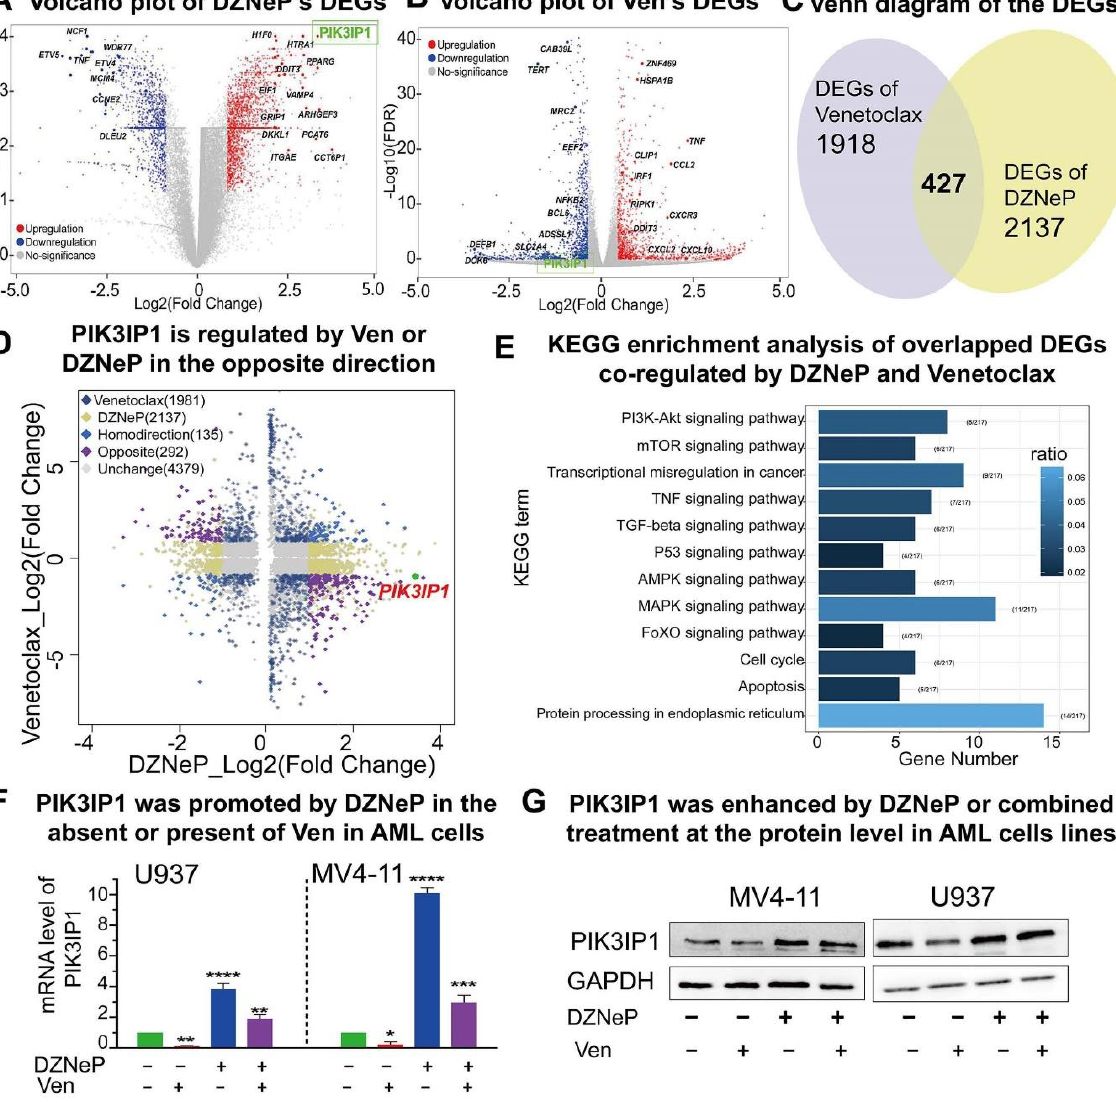
Figure 3. PIK3IP1 plays an important role in the synergistic anti-AML activity upon the combination therapy. ( A , B ) RNA-seq identified different expression genes (DEGs) of DZNeP or Ven treatment compared to the vehicle control in U937 cells. RNA-seq was performed with total RNA isolated from U937 cells treated with 2 μM of DZNeP, 7.5 μM of Ven, or vehicle for 48 h. ( C , D ) RNA-seq analysis identified 427 overlapped DEGs; 135 genes are regulated in the same direction, and 292 genes are regulated in the opposite, among which PIK3IP1 was induced by DNZeP while inhibited by Ven. ( E ) KEGG enrichment analysis of the overlapped DEGs identified the involved pathways co-regulated by DZNeP and Ven. ( F ) The mRNA expression level of PIK3IP1 induced by DZNeP or/and Ven was measured by qRT-PCR. *, p < 0.05, **, p < 0.01. ***, p < 0.001. ****, p < 0.0001. ( G ) The protein expression of PIK3IP1 induced by DZNeP or/and Ven was detected by western blot.